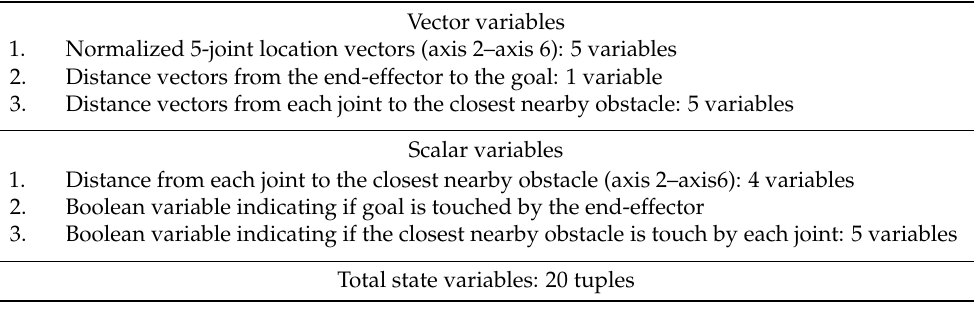
Table 1. State variables.